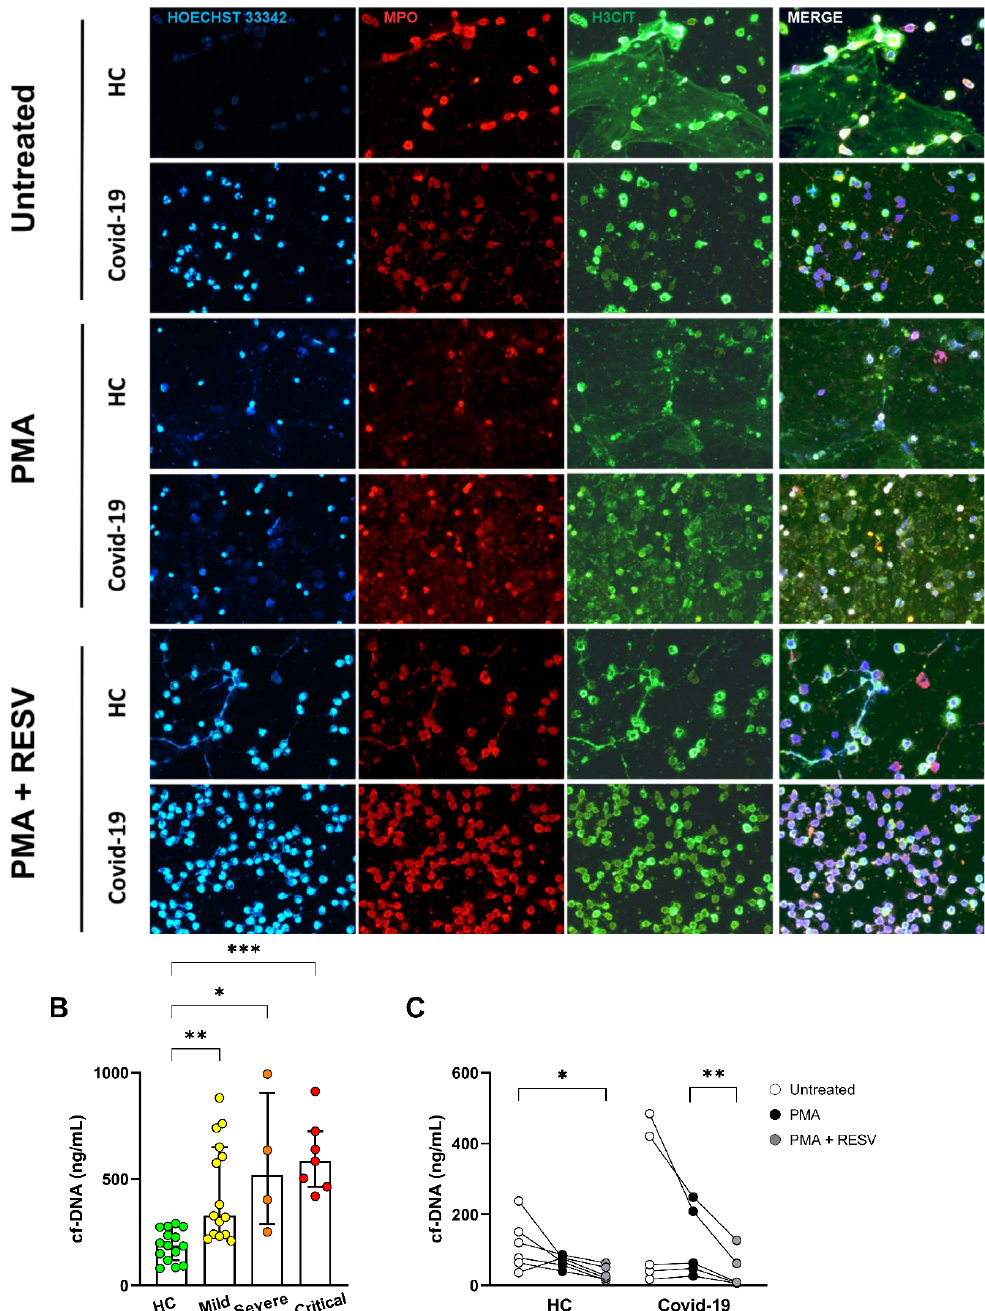
Figure 6. Resveratrol is able to modulate NET formation. ( A ) Representative immunofluorescence analysis of NETs release by neutrophils isolated from healthy controls and COVID-19 patient, cultured for 4 h at 37 ◦ C. Cells were stained for nuclei (Hoechst 33342, blue), MPO (red), and H3Cit (green). Original magnification 40x. ( B ) Determination of cell-free DNA (cf-DNA) in plasma from control subjects ( n = 15) and SARS-CoV-2 infected patients (Mild = 13; Severe = 4, Critical = 9) by Quant-iT PicoGreen. ( C ) Cell-free DNA in the supernatant of enriched neutrophil culture incubated with 100 µ M resveratrol 30 min and stimulated with PMA 4 h of healthy ( n = 6) and SARS-CoV-2 infected ( n = 5) subjects. Data represent the median and interquartile range. * p ≤ 0.05, ** p ≤ 0.01 and *** p ≤